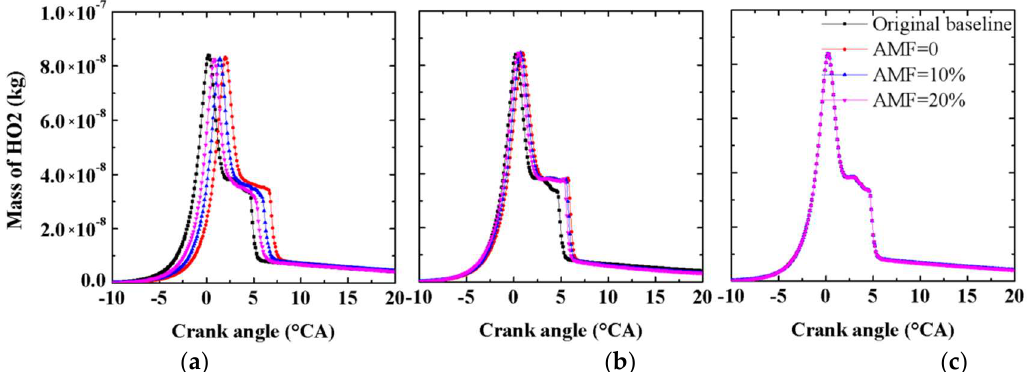
Figure 8. Mass of HO 2 radicals at different DI timings with variation of AMF: ( a ) DI timing = −105 °CA; ( b ) DI timing = 0 °CA; ( c ) DI timing = 40 °CA.